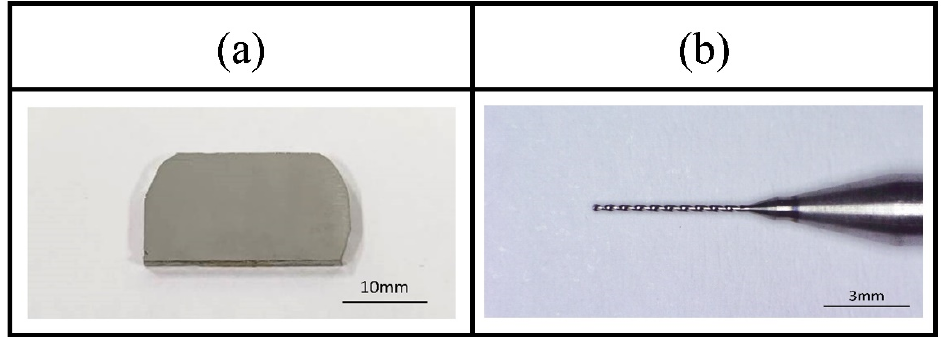
Figure 3. P hoto of the ( a ) Fe-based metallic glass plate. ( b ) Helical tungsten carbide electrode. Figure 3. Photo of the ( a ) Fe-based metallic glass plate. ( b ) Helical tungsten carbide